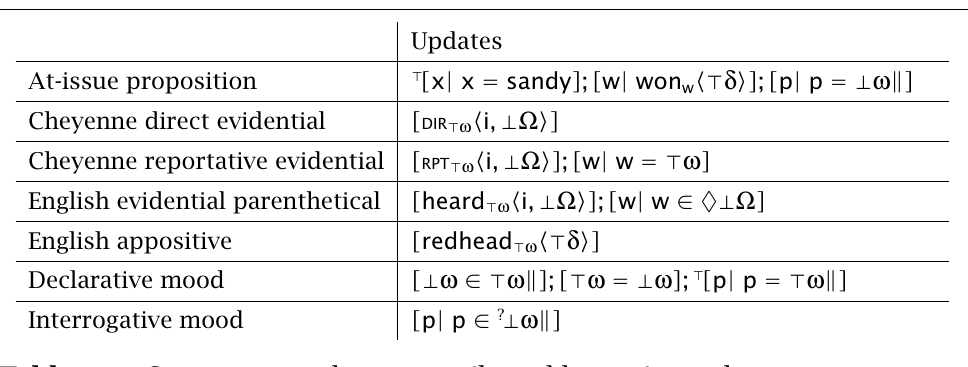
Table 7 Summary: updates contributed by various